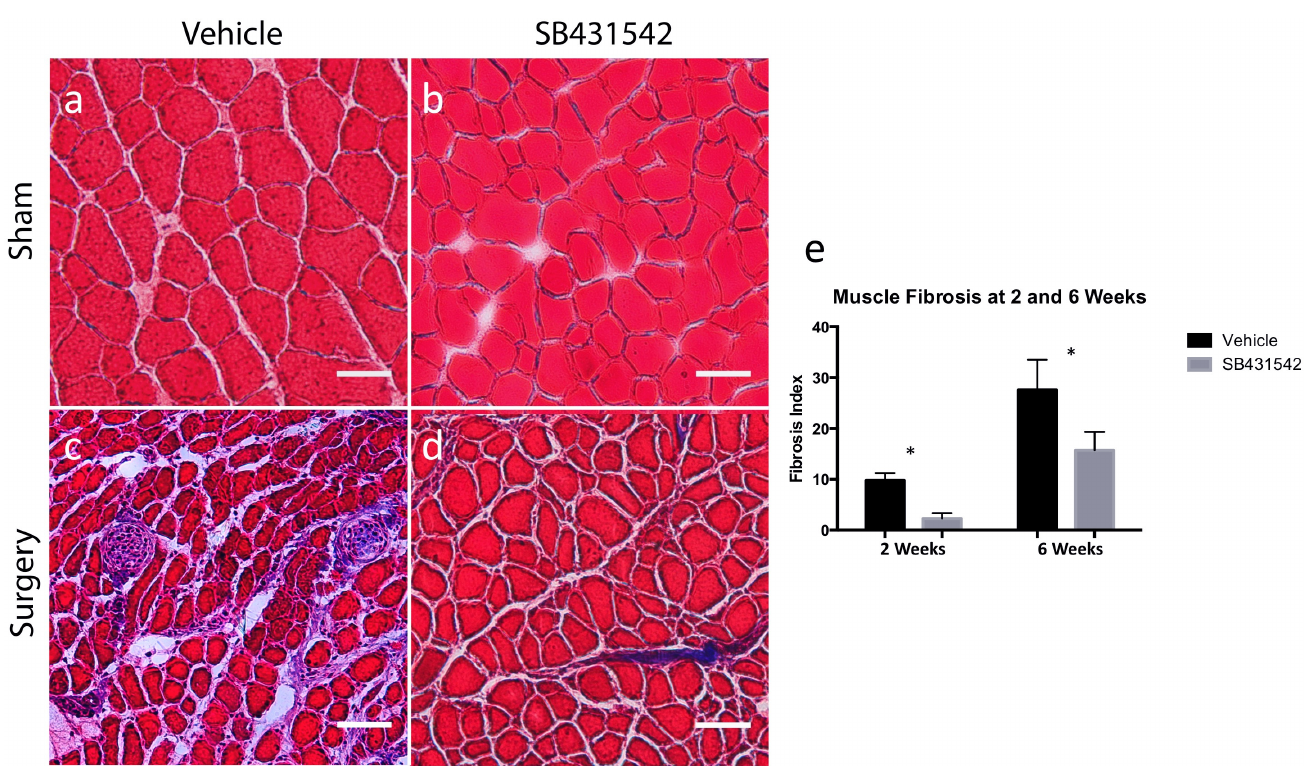
Fig 1. SB431542 reduces rotator cuff muscle fibrosis after injury. (a-d) Representative Masson trichrome stain of supraspinatus muscle sections at 6 weeks, scale bar = 50 μ m. (e) Quantification of injured muscle fibrosis indices at 2 and 6 weeks from 4 whole muscle sections/animal (N = 4/group) imaged at 5X magnification, * p <